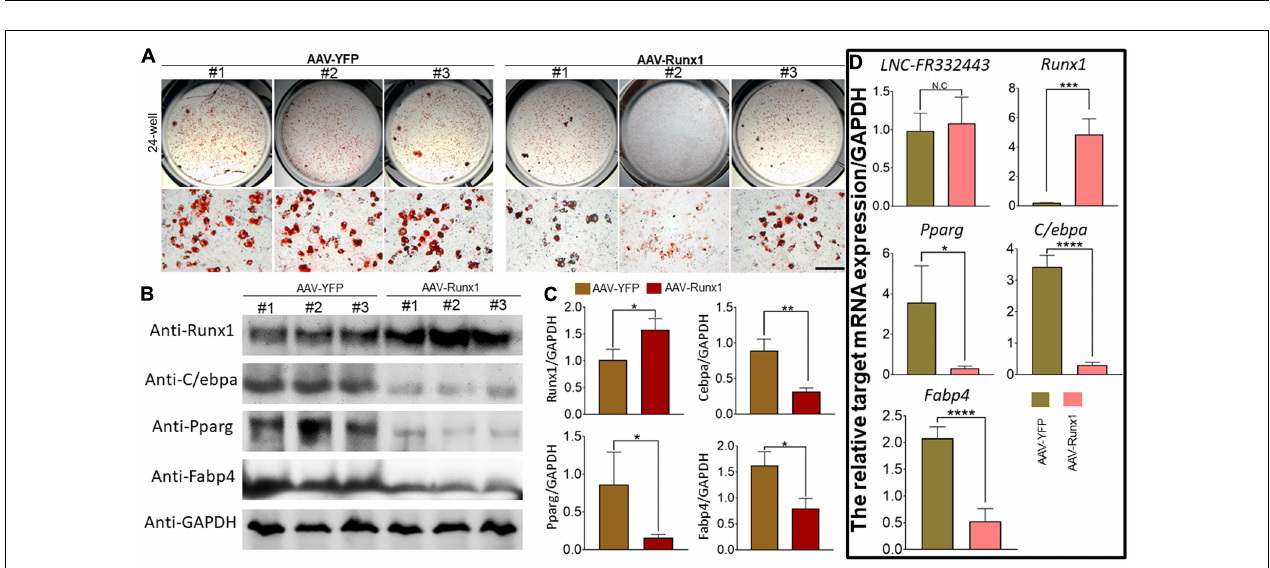
FIGURE 5 | Lnc-FR332443 inhibits 3T3-L1 preadipocyte differentiation in vitro . (A) Oil red O staining of 3T3-L1 preadipocytes transfected with Lnc-FR332443 siRNA and its control at day 4. Scale bar, 200 µ m. (B) The protein expression levels of Runx1 and the adipogenic markers PPAR γ , C/EBP α and FABP4 in the 3T3-L1 cells transfected with Lnc-FR332443 siRNA and its control. (C) Quantification data of panel (B) . (D) The mRNA expression levels of Lnc-FR332443, Runx1, PPAR γ , C/EBP α and FABP4 in the 3T3-L1 cells transfected with Lnc-FR332443 siRNA and its control. All data are presented as the mean ± SEM, NS denotes not significant, N = 4, * P < 0.05, ** P < 0.01, *** P < 0.001, and **** P < 0.001.